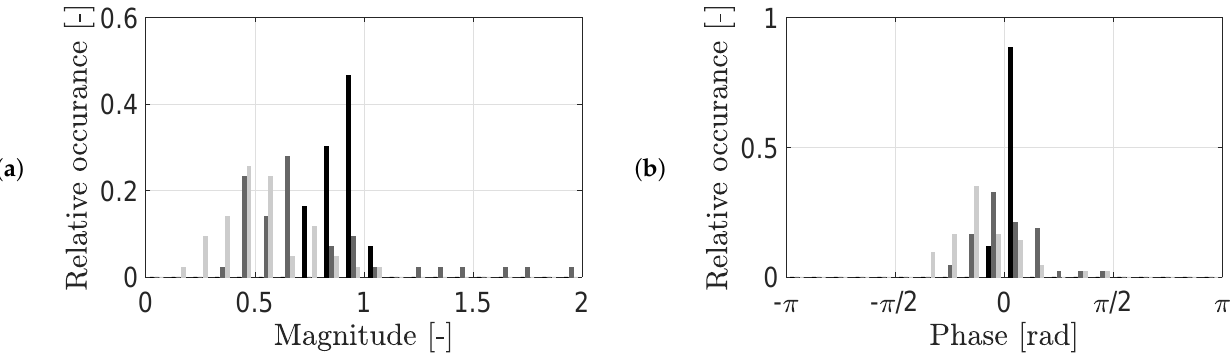
Figure 7. Histogram of the components of the estimated transfer function based for main harmonic 1 (black), 2 (dark gray) and 3 (light gray): ( a ) magnitude and ( b ) phase